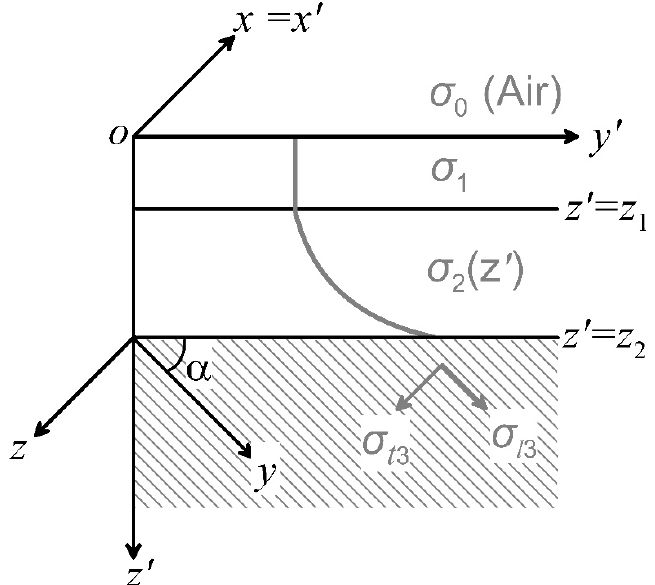
Figure 1. A 1D layered anisotropic model containing three layers. The black axes are for the coordinate system. The top layer is an isotropic layer of fixed conductivity σ 1 . The middle layer is a transitional layer of conductivity that varies exponentially with depth, represented by σ 2 ( z (cid:48) ) . The bottom layer is a dipping anisotropic bed of conductivities σ l 3 and σ t 3 in the longitudinal and transverse directions, respectively, in the o-xyz coordinate system. The variation in conductivity with depth in the top and middle layers are represented by the grey line and the curve, respectively, and the anisotropic conductivities in the bottom layer are marked by grey arrows. The dipping direction of the bottom bed makes an angle α with the horizontal interface.